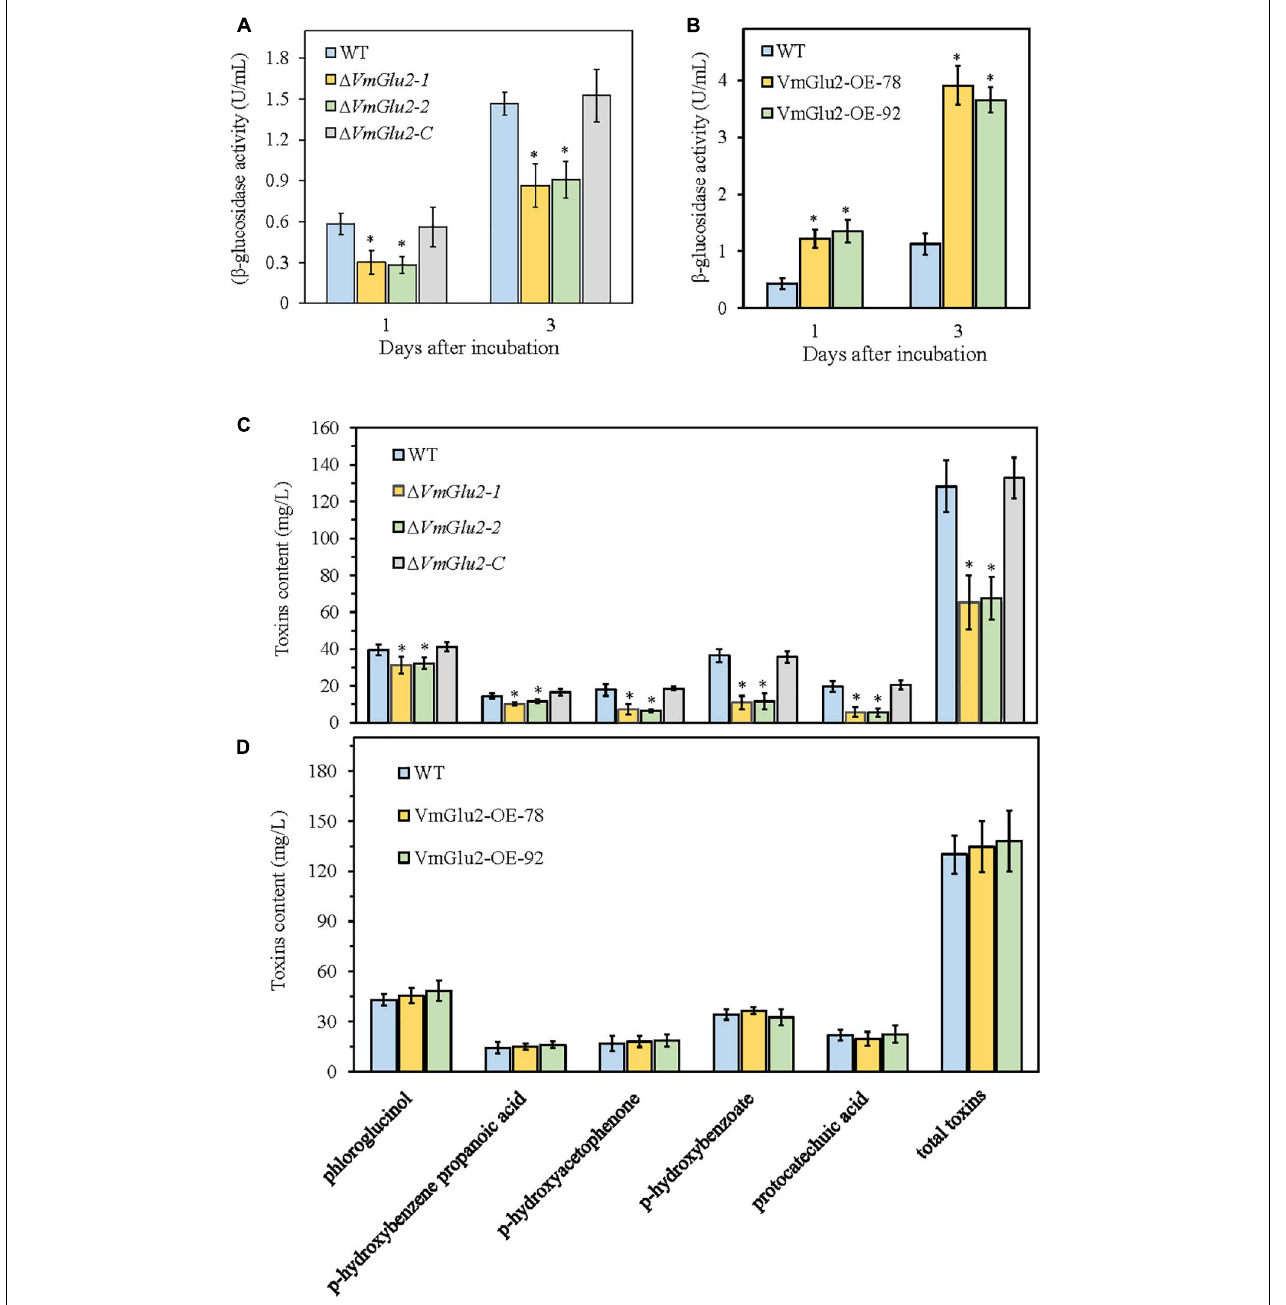
FIGURE 8 | Effect of VmGlu2 deletion and overexpression on the enzyme activity of β -glucosidase (A,B) and toxin production (C,D) in V. mali . The enzyme activity was measured in the apple branch extract media for different strains at 1 and 3 days after incubation. The pNPG was used as a substrate. Toxins contents were determined in the apple branch extract media for different strains after 7 days of growth. Bars indicate standard deviations of the mean of three replicates. Asterisks indicate significant differences in gene deletion mutants or OE transformants as compared to that in the wild-type strain ( P <